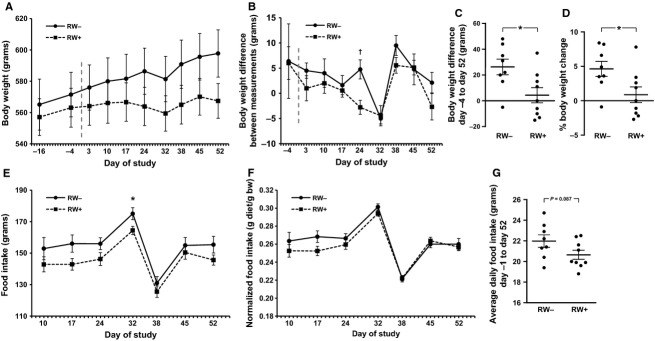
Body weight and food intake. Body weight was measured approximately weekly following receipt of animals and for 8 weeks following the start of the RW protocol (indicated by vertical hashed line) (A). Differences in consecutive body weight measurements (B). Absolute body weight differences (C) and percent body weight changes (D) between 4 days preceding and 52 days following onset of RW protocol. Approximately weekly food intake (E) and food intake normalized to body weight (F). Average daily food intake between 1 day preceding and 52 days following onset of RW protocol (G). *P < 0.05, †P < 0.01. Values represent the mean ± SE. Dot plots show values from individual rats; middle horizontal bars represent the mean ± SE (C,D,G). RW−, no running wheel access; RW+, continuous running wheel access.